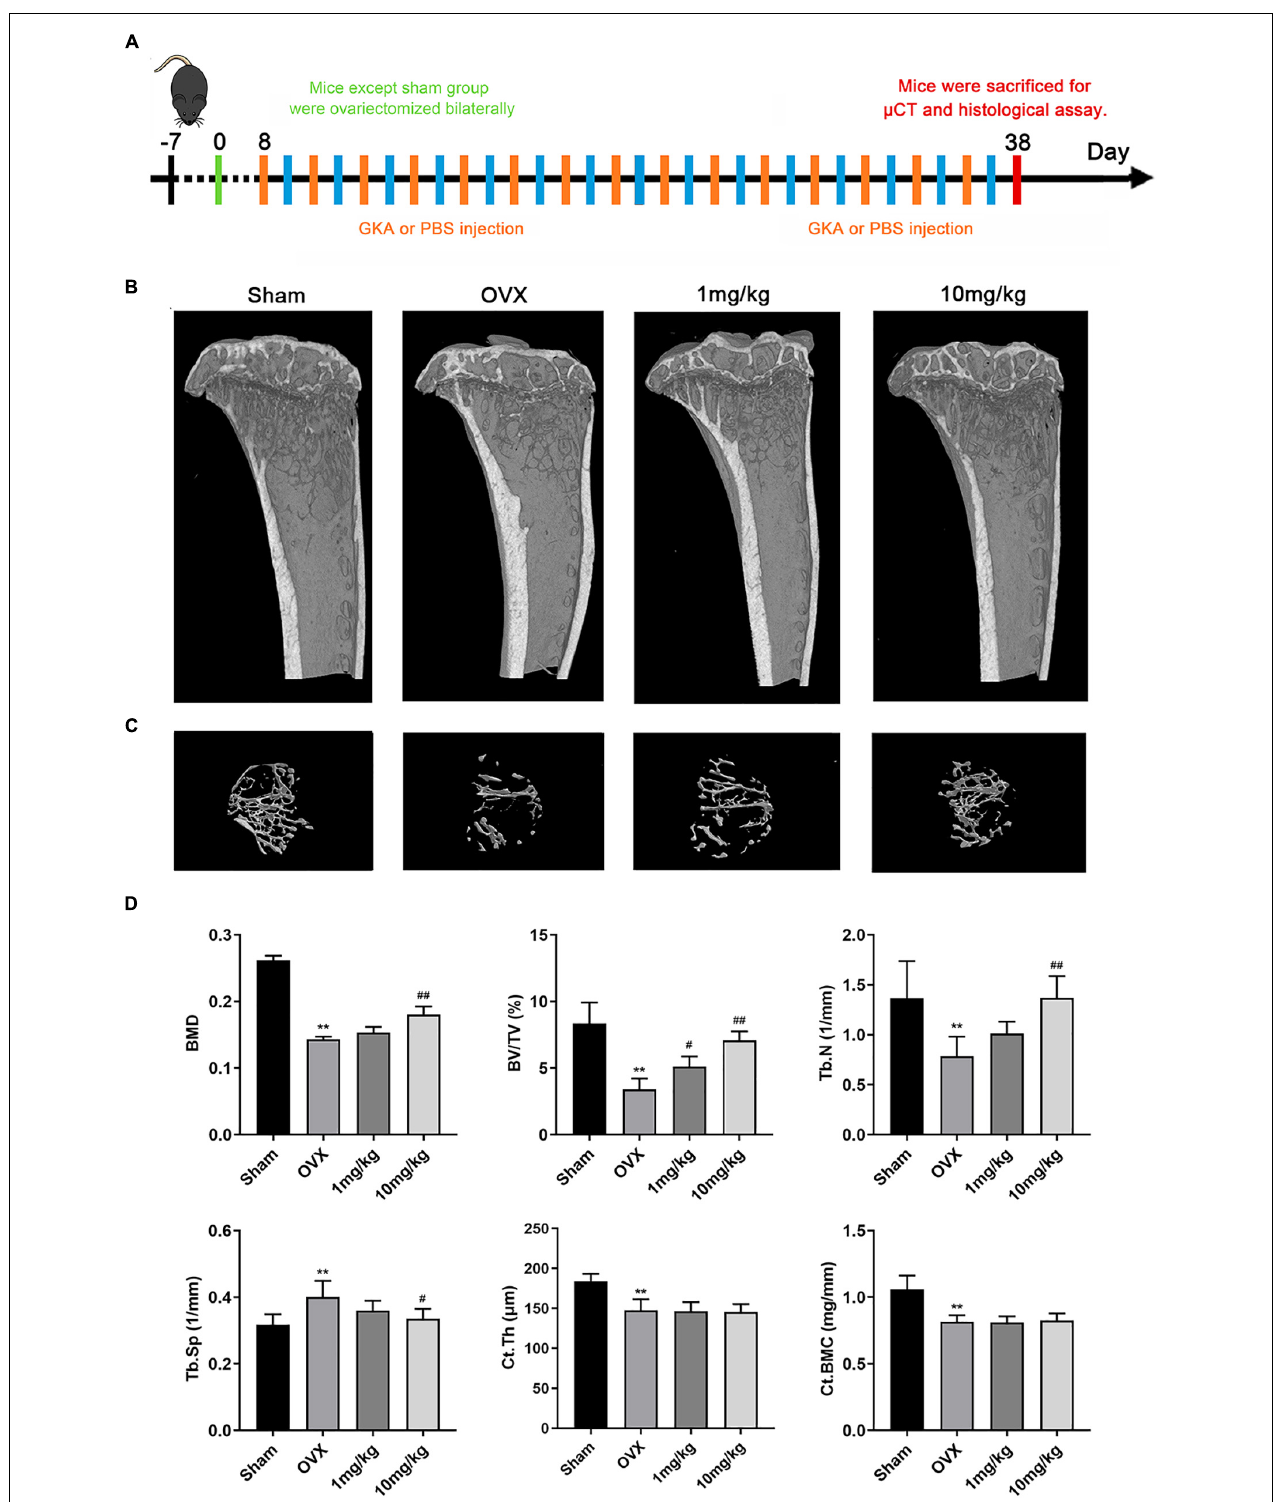
FIGURE 5 | GKA prevented ovariectomy-induced bone loss in vivo . (A) Treatment regimen. (B) Representative images of tibia in sham, OVX, low-dose (1 mg/kg), and high-dose (10 mg/kg) groups. (C) 3D reconstructions of the tibial bone in 4 groups. (D) Quantification of bone morphometric parameters of BMD, BV/TV, Tb.N, Tb.Sp, Ct.Th, and Ct.BMC in 4 groups. The data were presented as the mean ± SD (** P < 0.01 compared with the sham group, # P < 0.05, ## P < 0.01 relative to the OVX group, analyzed by one-way ANOVA, followed by multiple comparisons per test; n = 6).